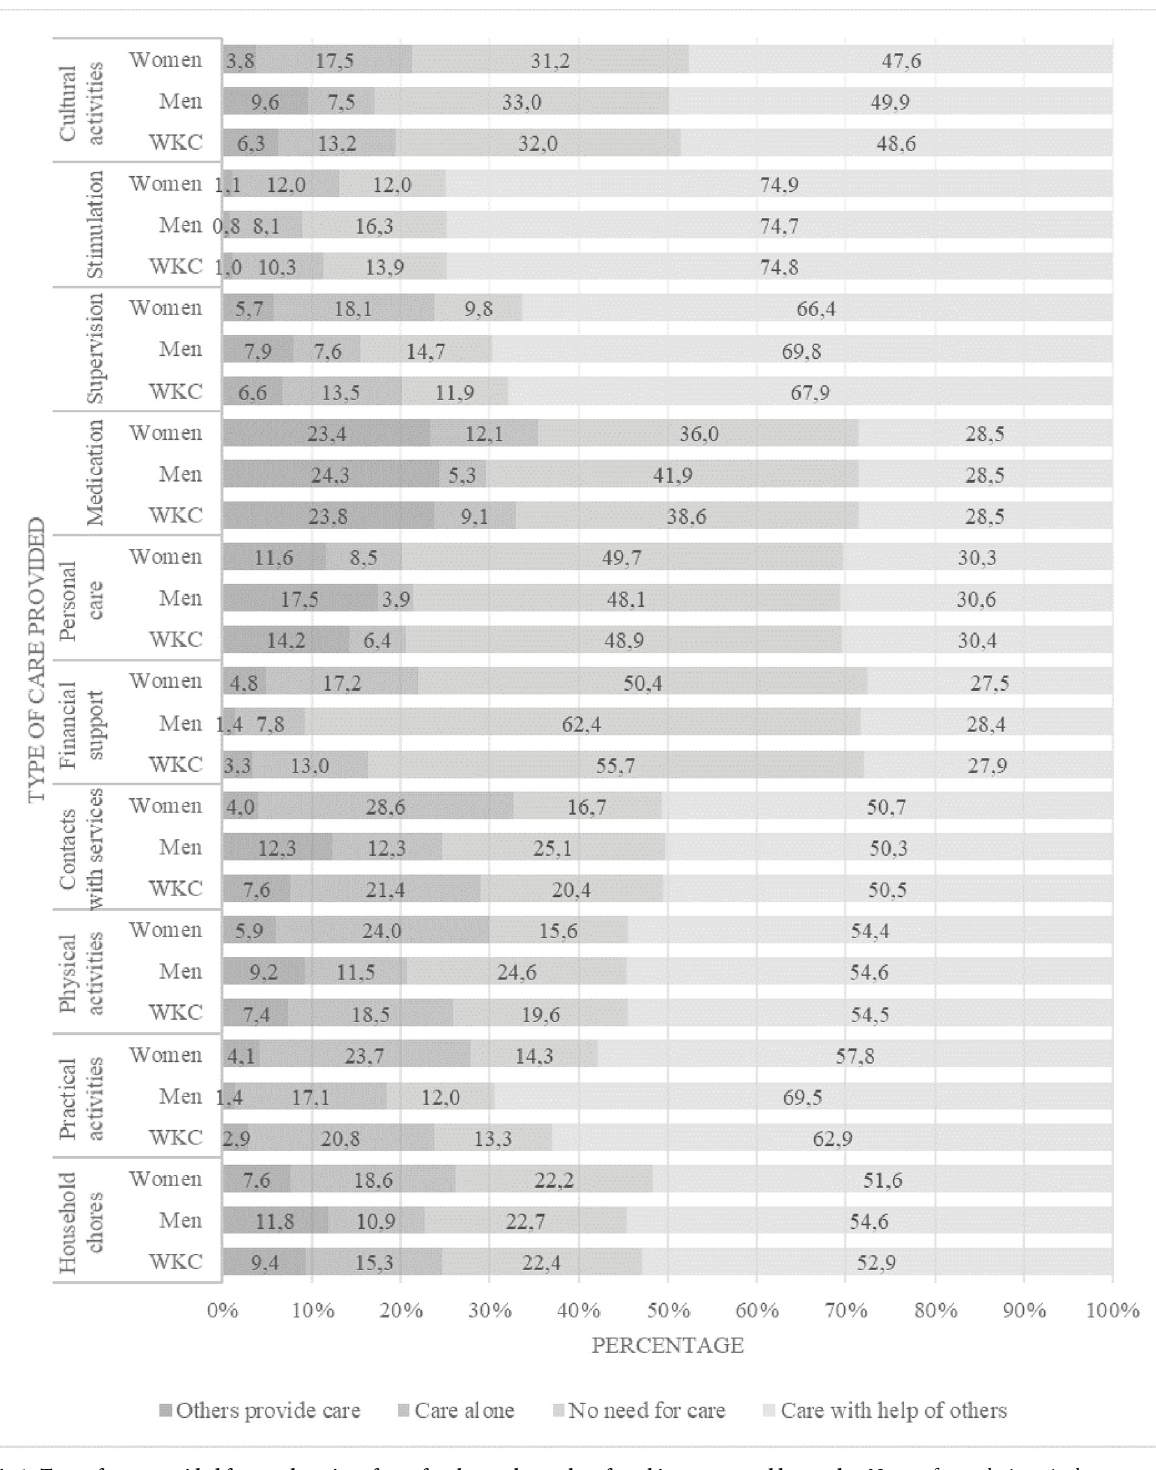
PLOS ONE | https://doi.org/10.1371/journal.pone.0263396 March 7,